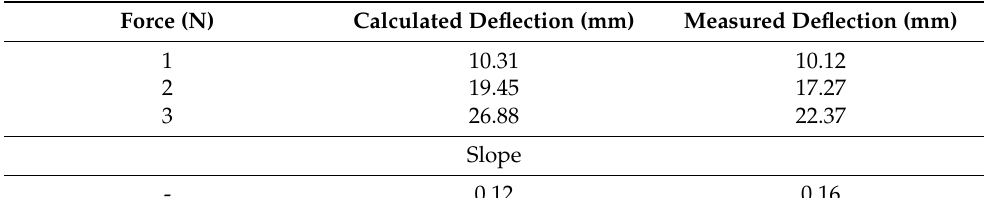
Table 3. Comparison of predicted and measured response to applied force.